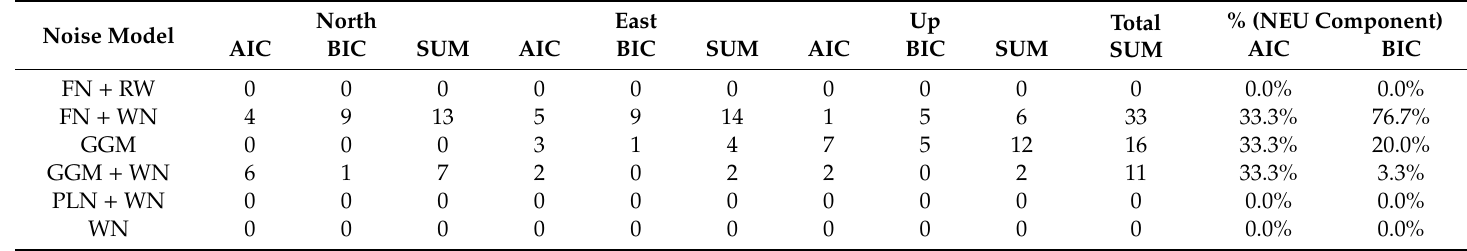
Table 4. Number of times that each noise model had the lowest AIC or BIC values for the North, East, and Up component based on the BERN time-series solution